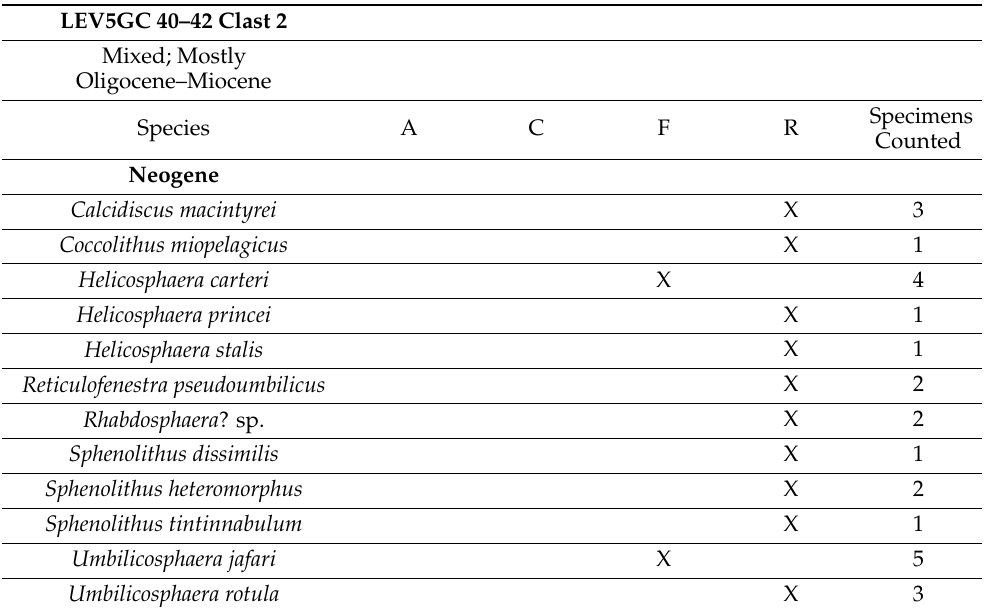
Table A21. Moscow